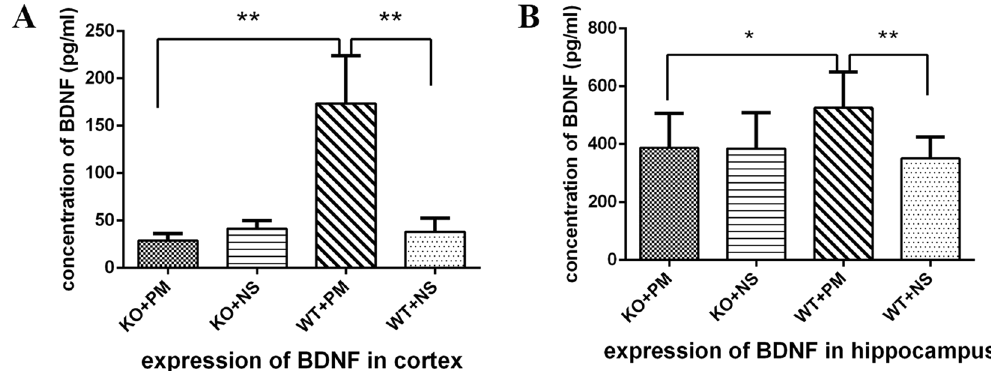
Figure 6. BDNF protein levels in the cortex and hippocampus at 24 h after inoculation with S. pneumoniae . BDNF in the cortex ( A ) and hippocampus ( B ) were significantly higher in infected wild-type mice than in control wild-type mice and infected myd88 − / − mice. * p < 0.05, ** p < 0.01. BDNF: brain-derived neurotrophic